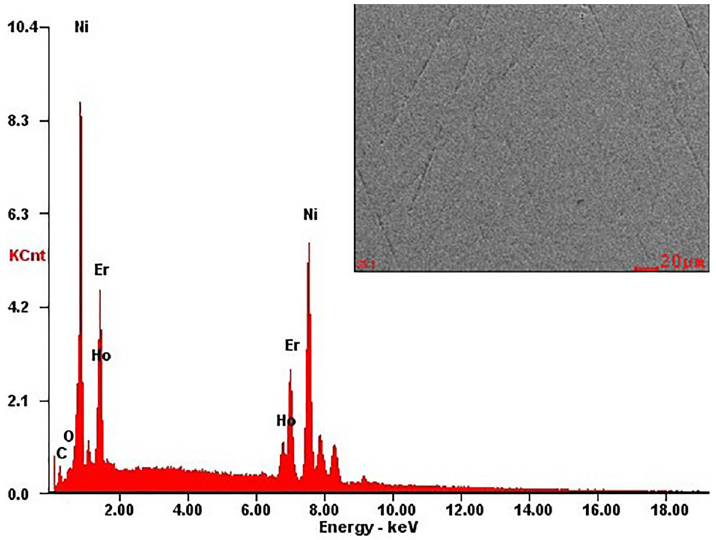
Figure 2. Energy-dispersive x-ray (EDX) analysis data for the Ho 0.25 Er 0.75 Ni 2 solid solution and SEM image (with secondary electrons contrast) of the typical polished